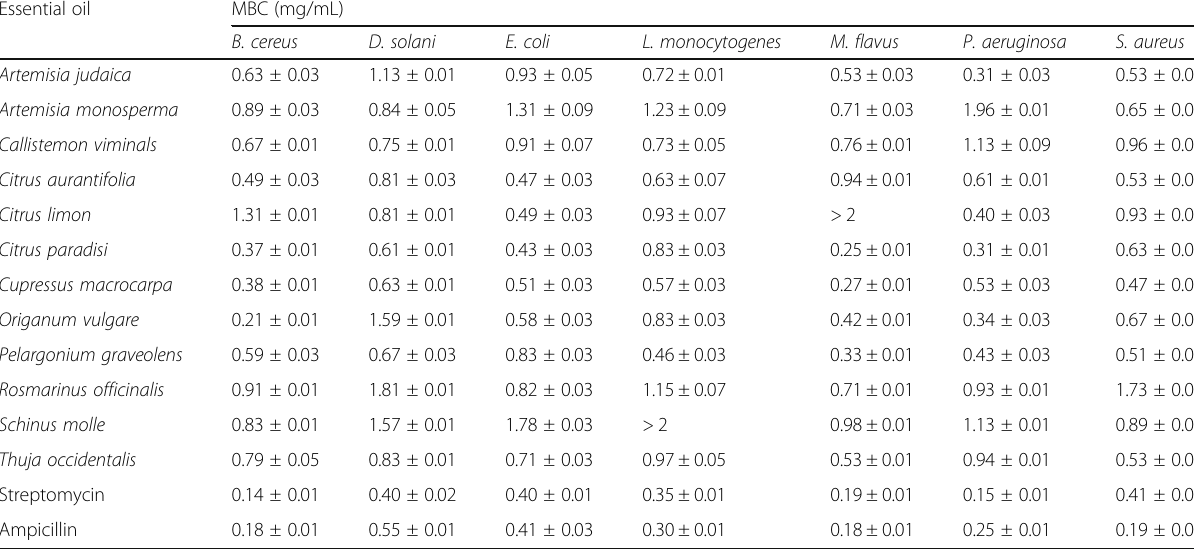
Table 6 Minimum bactericidal concentration (MBC) of essential oils on bacterial strains Essential oil